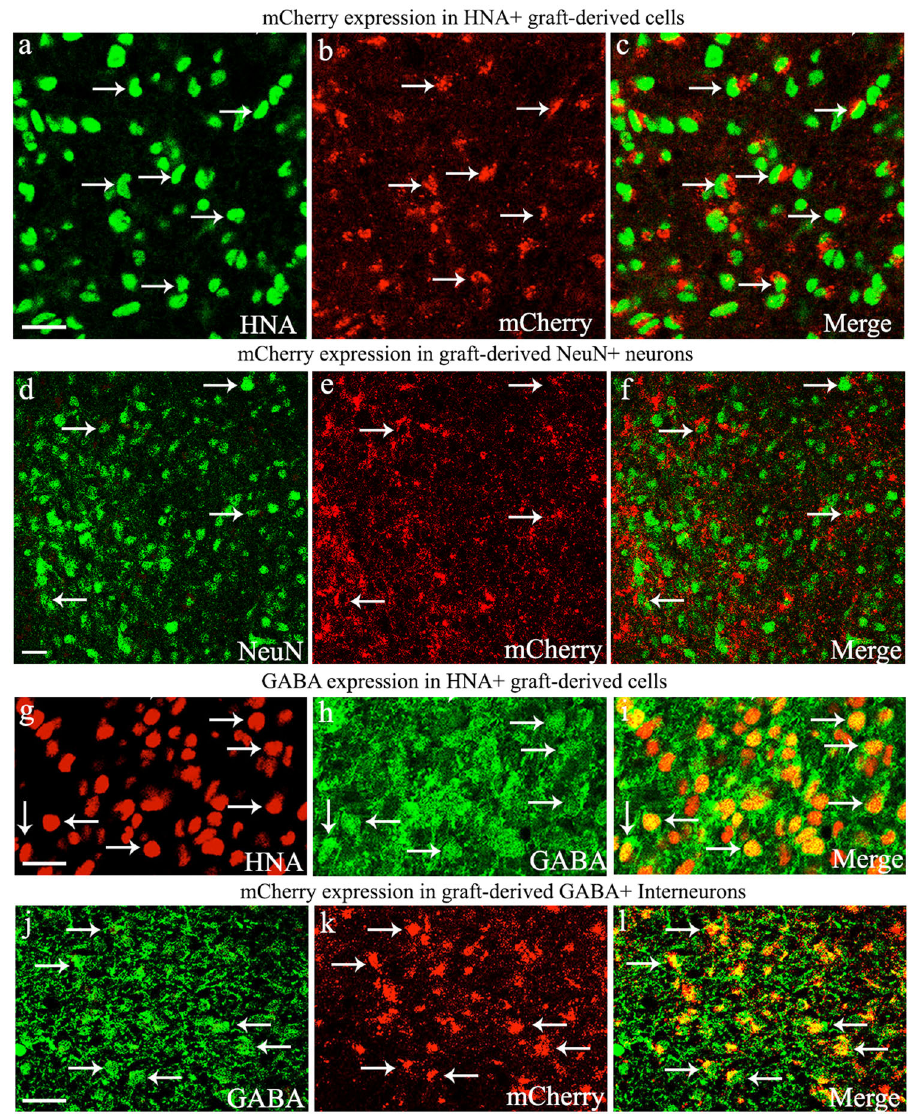
Fig. 6 Evaluation of Gi-protein-coupled receptor hM4Di expression (with mCherry reporter) in human nuclear antigen-positive (HNA + ) cells, neuron-speci fi c nuclear antigen-positive (NeuN + ) neurons, and gamma-aminobutyric acid-positive (GABA + ) interneurons derived from human medial ganglionic eminence progenitor cell grafts in the hippocampus of chronically epileptic rats. Note that mCherry is displayed in virtually all HNA + graft-derived cells ( a – c ), NeuN + neurons ( d – f ), and GABA-ergic interneurons ( j – l ). g – i demonstrate that a vast majority (mean ± S.E.M, 80.8 ± 1.1%) of HNA + graft-derived cells differentiated into GABA-ergic interneurons. Scale bars: a – l , 20